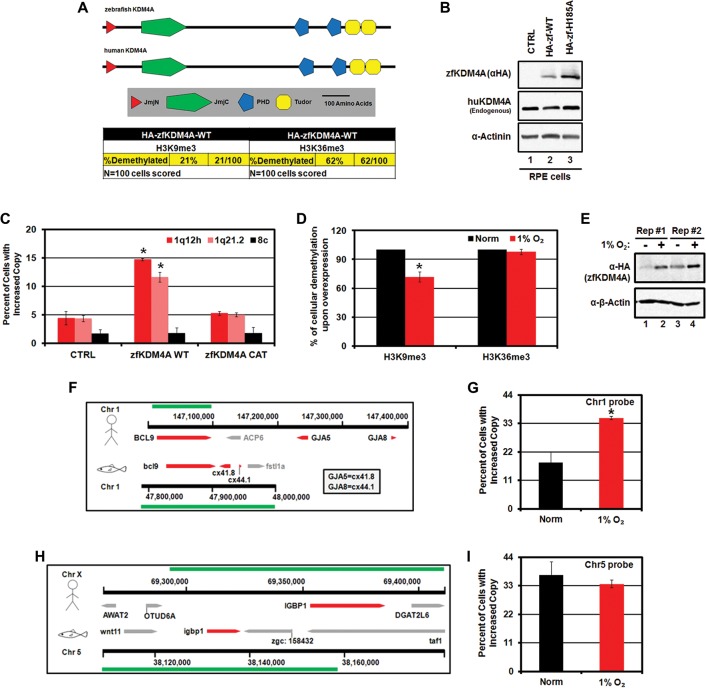
Hypoxia-induced copy gains are conserved in zebrafish. (A) A schematic depicting the homology of huKDM4A and zfKDM4A. The table depicts the H3K9 and H3K36 demethylase activity of zfKDM4A expressed in RPE cells as determined by immunofluorescence. (B) Expression levels of zfKDM4A and huKDM4A proteins in RPE cells expressing wild-type (WT) and catalytically mutant (H185A) zfKDM4A. (C) zfKDM4A promotes copy gain in human cells. Quantification of FISH for 1q12h, 1q21.2, and 8c for RPE cells expressing zfKDM4A or catalytically inactive zfKDM4A CAT. (D) Quantification of H3K9 and H3K36 demethylase activity by immunofluorescence in normoxia and hypoxia for RPE cells ectopically expressing zfKDM4A. (E) Hypoxia stabilizes zfKDM4A in RPE cells. (F) A schematic depicting the syntenic region of 1q21.2 in zebrafish used for FISH analysis. Green bars indicate the location of the human (stick figure) and zebrafish (fish icon) probes used. (G) Hypoxia promotes copy gain of BCL9 in zebrafish AB.9 cells. Quantification of FISH for BCL9 after 72 h of normoxia or 1% O2. (H) A schematic of the IGBP1 homologous region in zebrafish. Green bars indicate the location of the human (stick figure) and zebrafish (fish icon) probes used. (I) Hypoxia does not induce copy gain of IGBP1 in zebrafish. Quantification of FISH for IGBP1 after 72 h of normoxia or 1% O2. Error bars represent the SEM. (*) Significant difference from control samples by two-tailed Student's t-test. P < 0.05.